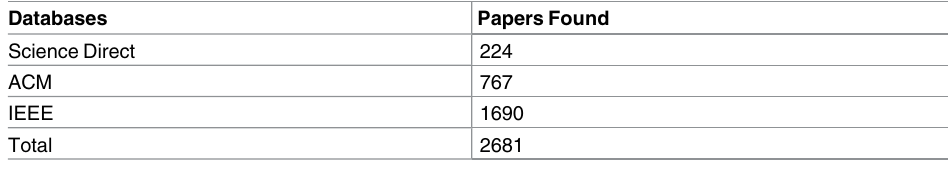
Table 3. Identified primary studies from databases.